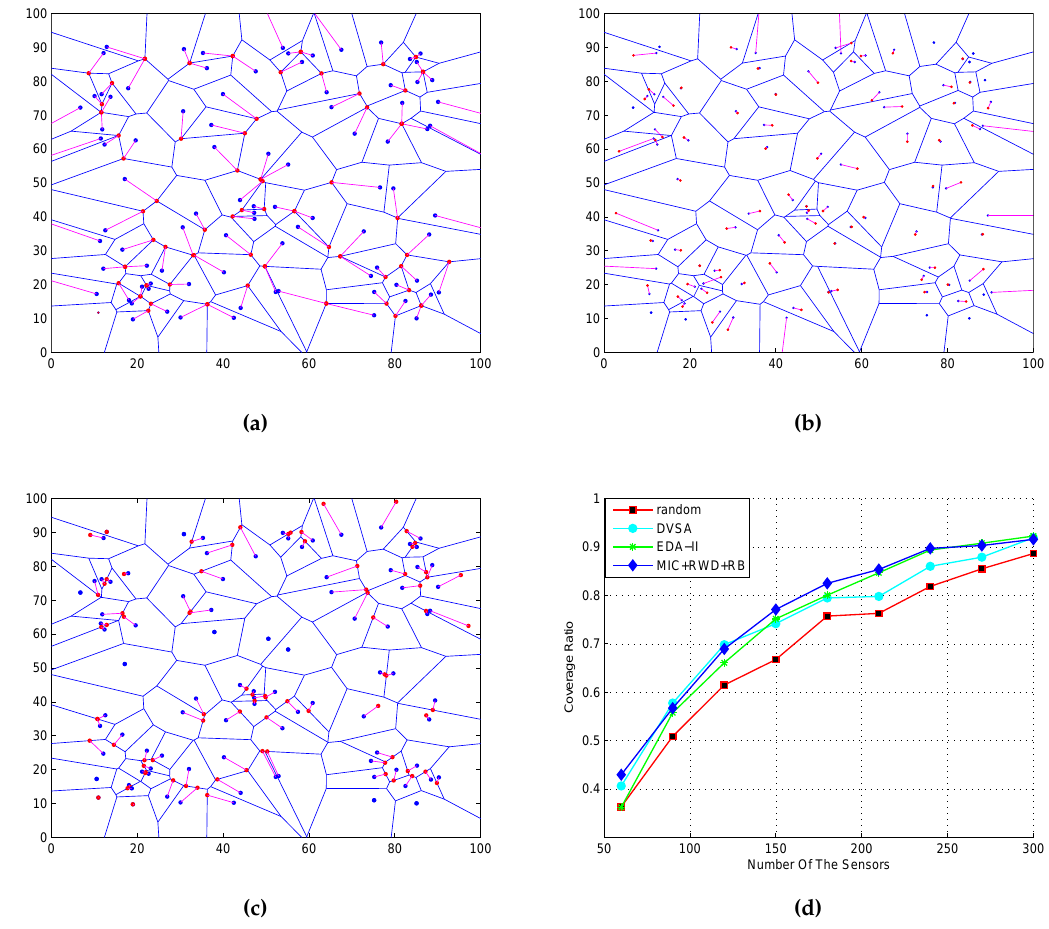
Figure 9. Moving track and coverage ratio. ( a ) DVSA; ( b ) EDA-II; ( c ) MIC; ( d ) coverage